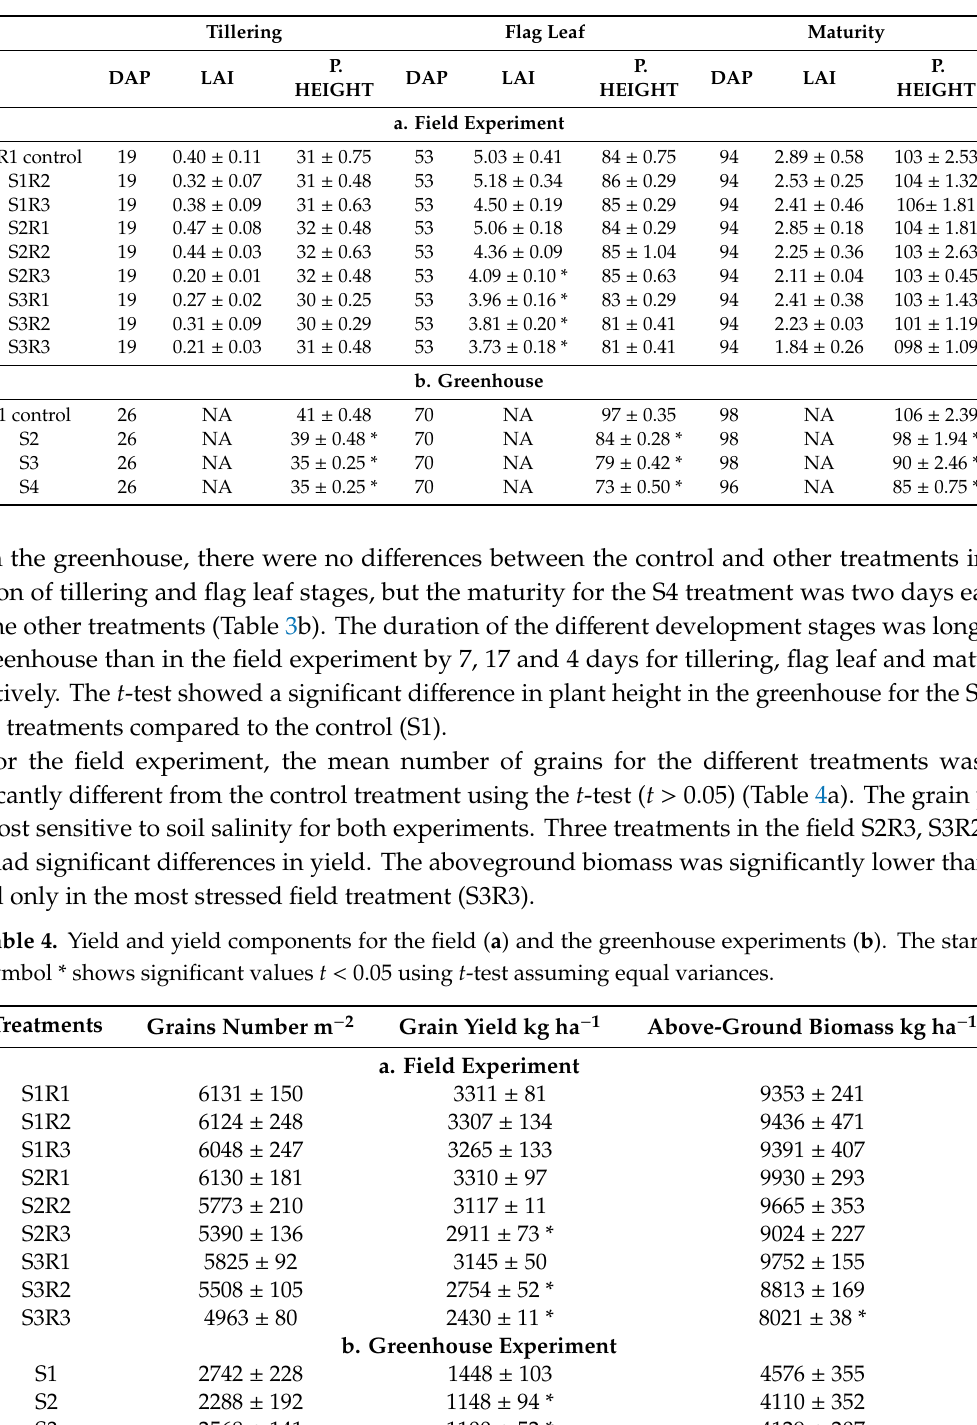
Table 3. Days after planting (DAP), leaf area index (LAI, m 2 m − 2 ) and plant height (P.HEIGHT, cm) for the tillering, flag leaf and maturity growing stages for the field experiment ( a ), and for the greenhouse experiment ( b ). The star symbol * shows significant values t < 0.05 using t -test assuming equal variances.